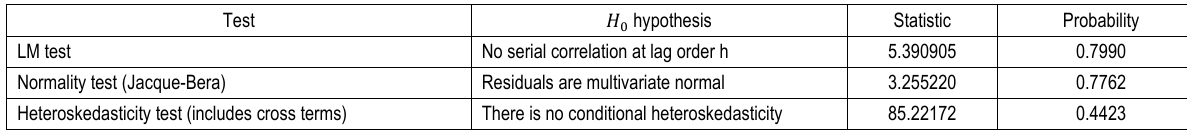
Table 10. Diagnostics tests